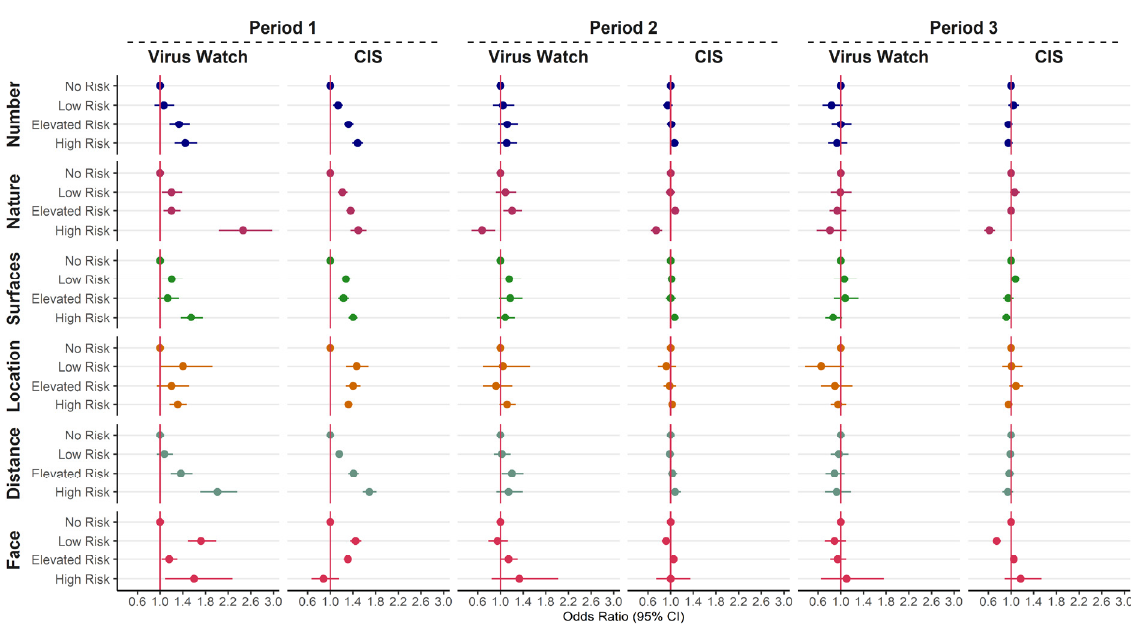
Figure 2. Odds ratios for COVID-19 by level of exposure for 6 domains of the job exposure matrix (compared to the no risk group) from [Virus Watch (N=16 801) and COVID-19 Infection survey (CIS) (N=244 470)] participants in work and aged 20-64. Data split into 3 time periods and models adjusted for age, sex, ethnicity, index of multiple deprivation (IMD) , region, household size, urban versus rural area, and presence of health conditions. See table 1 for explanation of abbreviations. Domains relating to insecurity and migrant workers not displayed here due to imprecision. Domain descriptions can be found in table